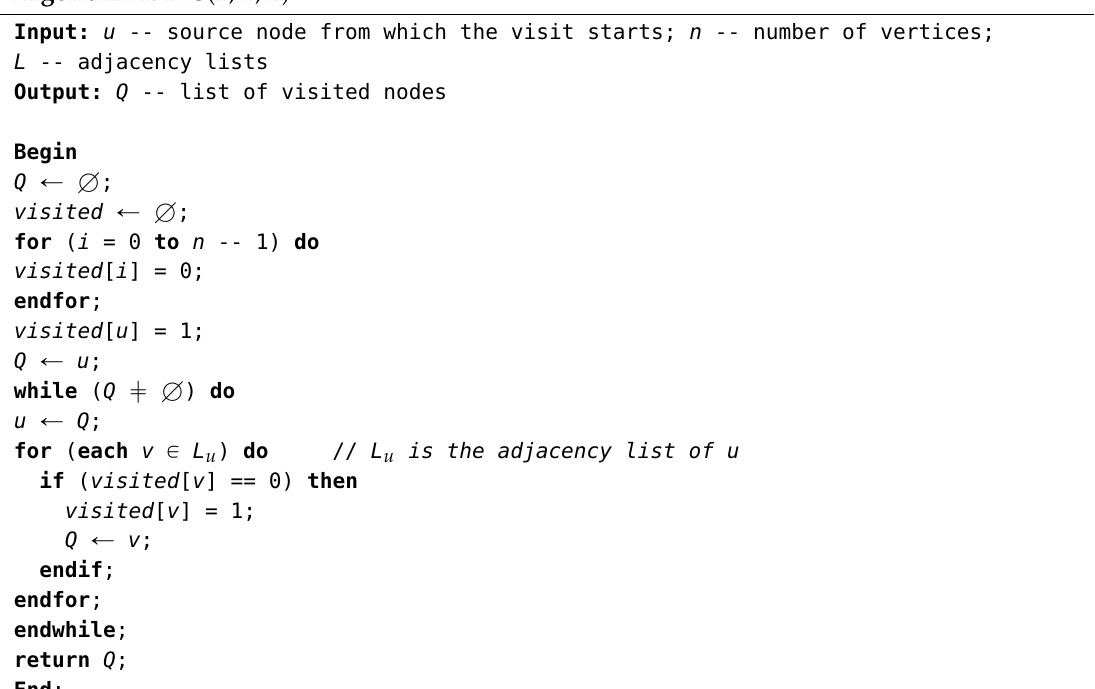
Algorithm 1: BFS( u , n , L